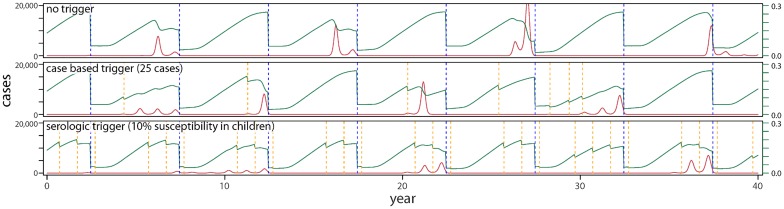
Typical time-series of incidence for three vaccination scenarios in a Yemen-like population: (i) a baseline scenario of routine vaccination combined with SIAs every 5 y; (ii) this baseline combined with campaigns that are triggered by a threshold number of cases; and (iii) this baseline combined with campaigns triggered by a threshold degree of serology in a target population age range.Red lines indicate number of cases, green lines susceptibility in children under 5 y of age, dashed blue lines the time of SIA occurrence, and dashed orange lines the timing of TCs.